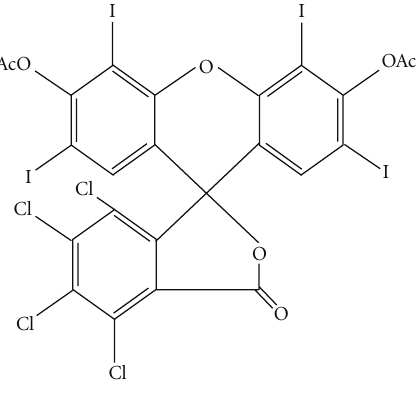
Figure 2: Rose Bengal diacetate